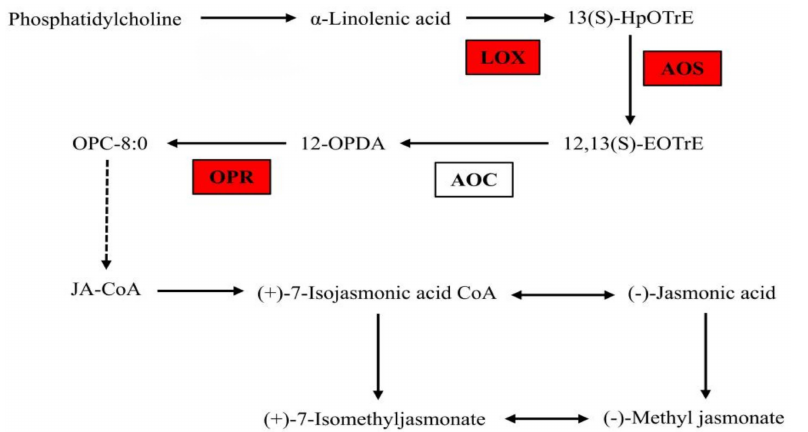
Figure 5. Differentially expressed genes involved in JA synthesis. Red refers to the significantly up-regulated genes. LOX (lipoxygenase); AOS (allene oxide synthase); AOC (allene oxide cyclase); OPR (12 − oxophytodienoic acid